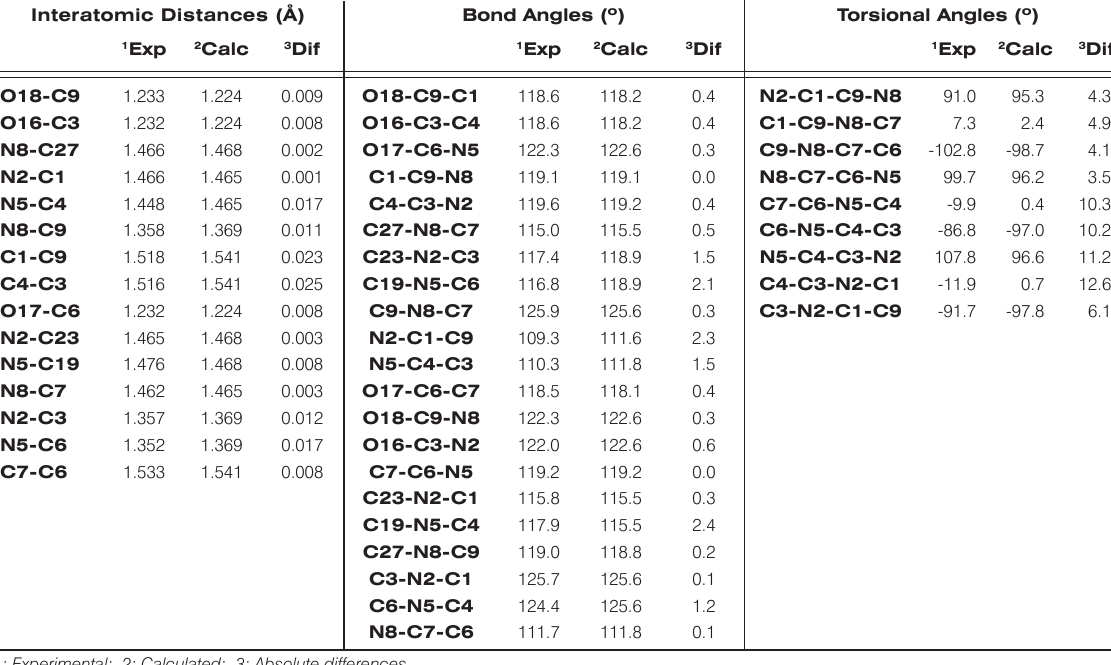
Table 2. Interatomic Distances (Å) Bond Angles